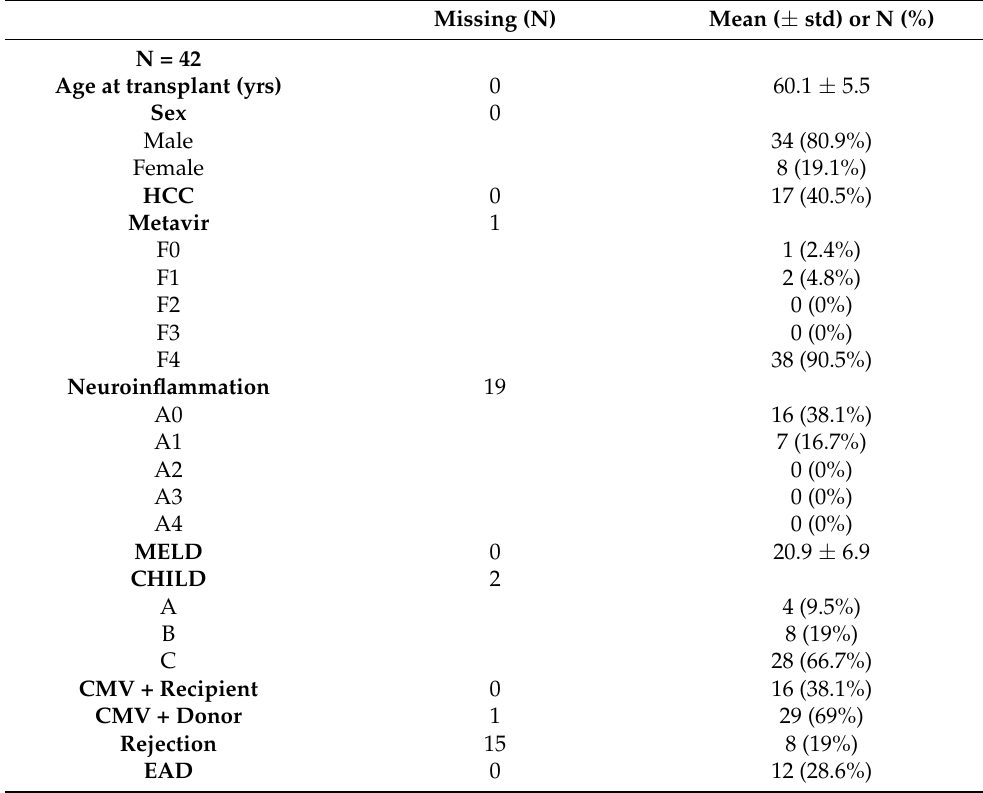
Table 8. Clinical and biological characteristics of the cohort of alcoholic cirrhosis (N = 40). N is corresponding to the number of